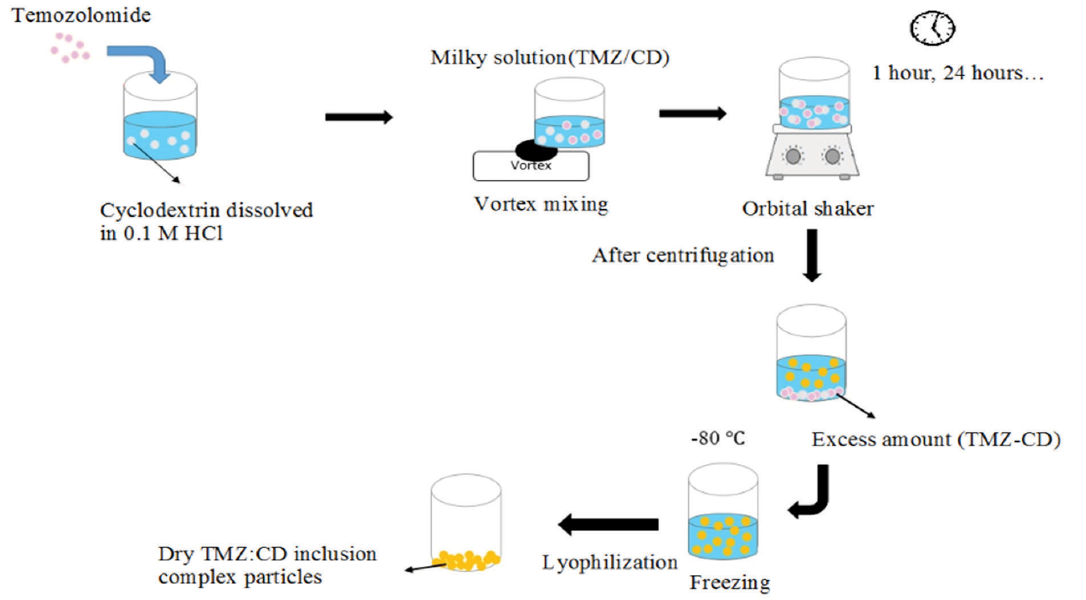
FIGURE 3 - Preparation process of TMZ-CD inclusion